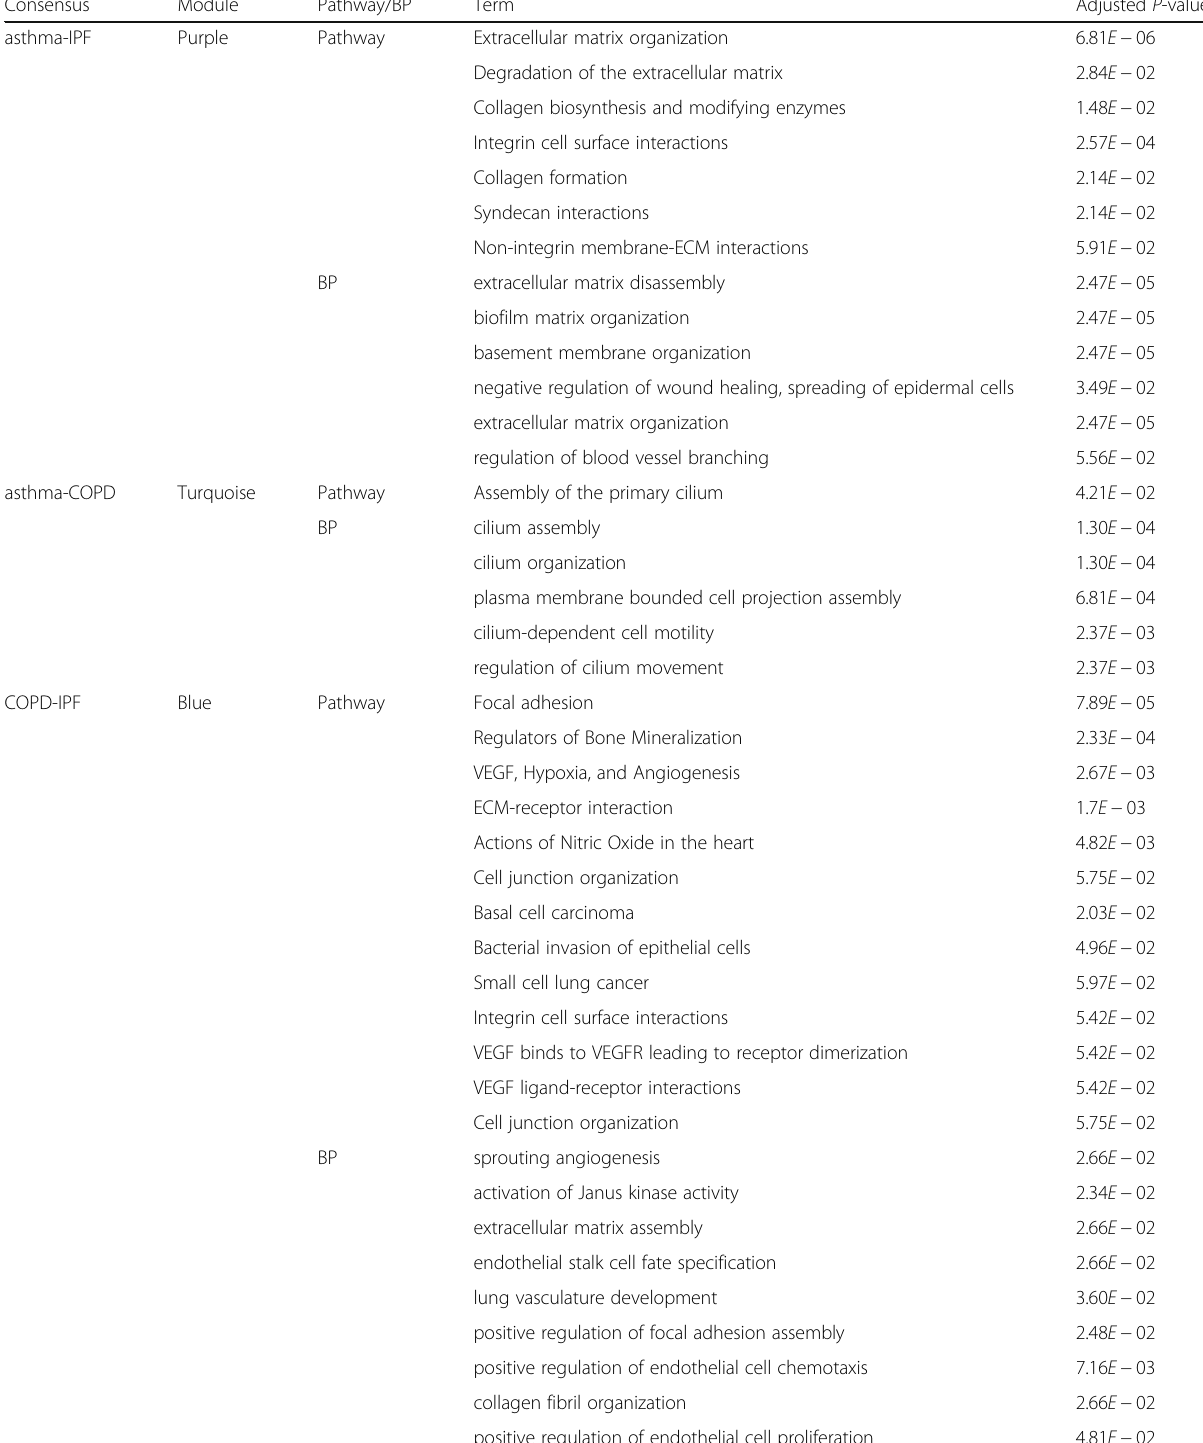
Table 6 Results of the Pathway and GO Biological Process Enrichment Analysis of Several Important Consensus Modules